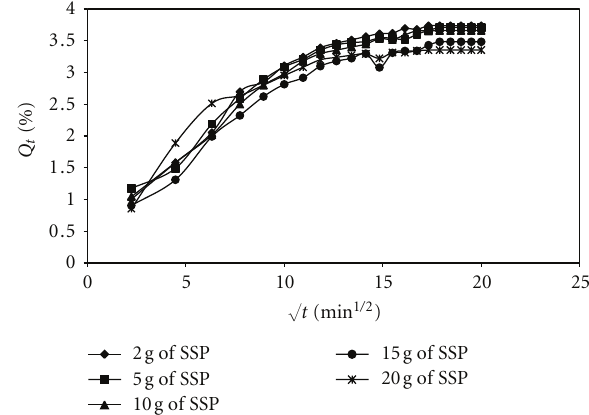
√ t (min 1 / 2 ) for snail shell powder